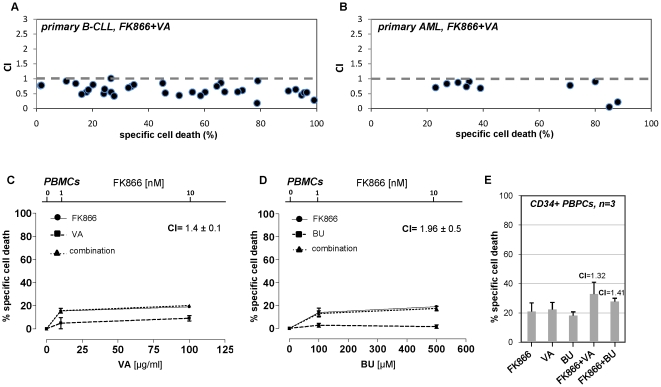
FK866/HDAC inhibitor synergistic interaction spares healthy leukocytes and CD34+ PBPCs.A, B, Primary B-CLL or AML cells were incubated with or without 10 nM FK866 for 48 h. Thereafter, 100 µg/ml VA was added (or not) to the medium. 48 h later, dead cells were quantified by PI-staining and flow-cytometry. CIs for the combination FK866/VA were calculated and plotted vs. the specific cell death induced by the same drug combination in each sample. C, D, Healthy PBMCs were incubated with or without FK866 at the indicated concentrations for 48 h. Thereafter, VA or BU were added at the indicated concentrations. Viability was assessed 48 h later by PI cell staining and flow cytometry. CI values refer to the highest drug concentrations used. E, Healthy CD34+ PBPCs were incubated in 96-well plates and treated with 10 nM FK866 for 48 h. Subsequently, 100 µg/ml VA or 500 µM BU were added where indicated. Viability was assessed 48 h later. CI values for the drug combinations are indicated inside the graph area. C–E, Results are means of three separate experiments with three different donors.